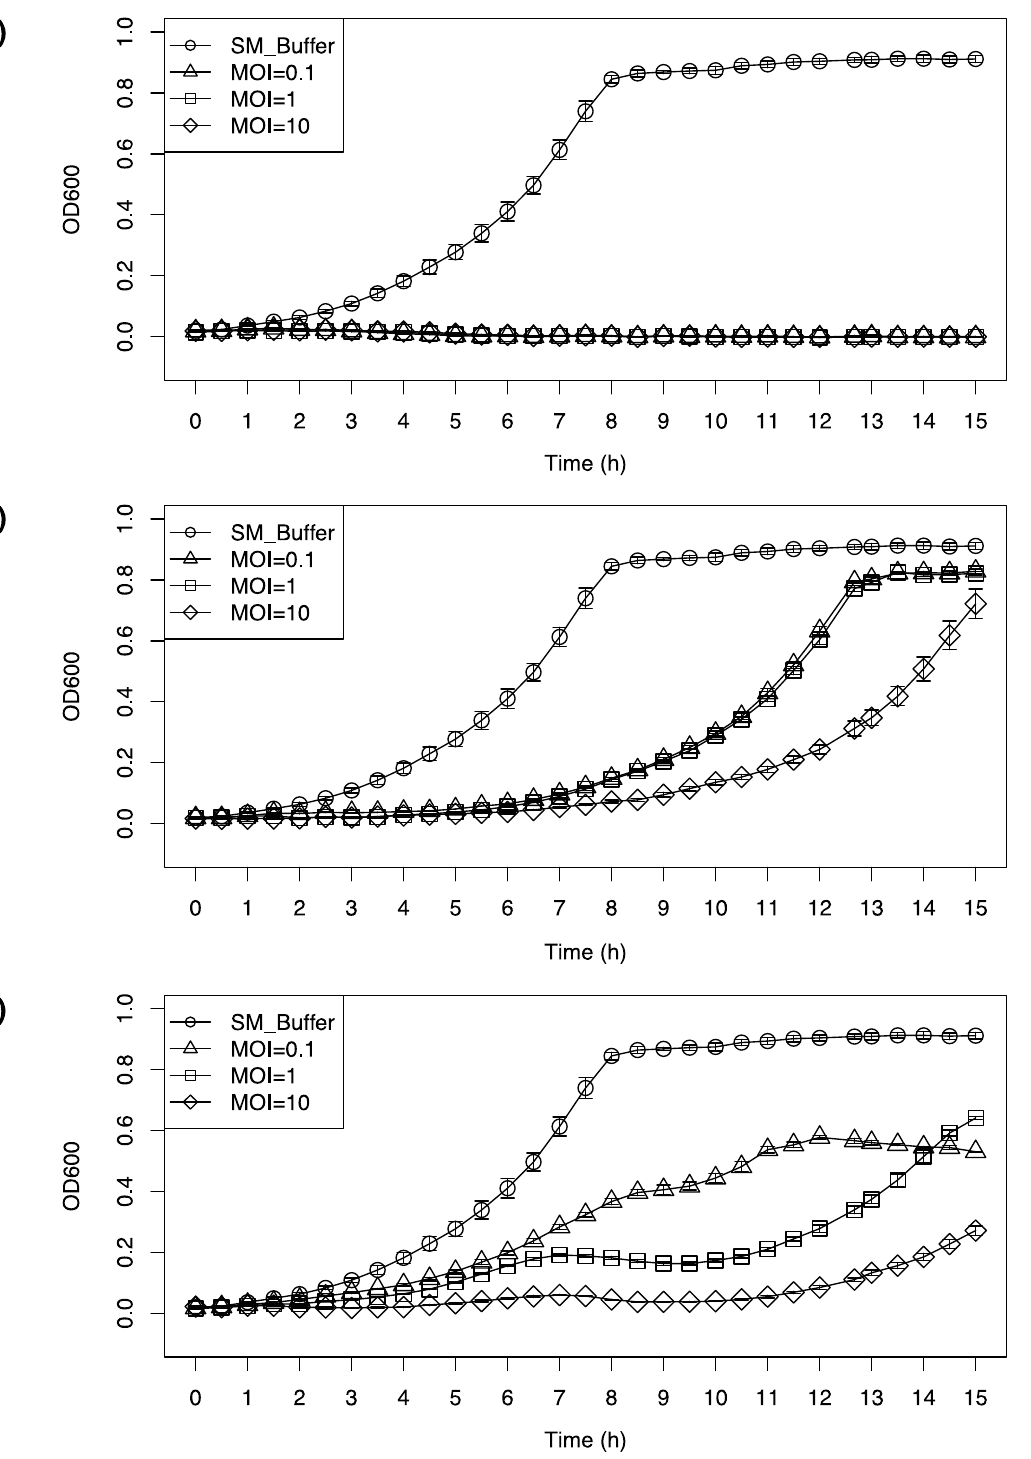
Figure 5. Inhibition growth curve of Listeria monocytogenes F2365 treated with ( A ) LP-020, ( B ) LP-027 or ( C ) LP-094 at different MOIs. Unfilled circles represent SM buffer control, unfilled triangles represent samples treated at an MOI of 0.1, unfilled squares represent samples treated at an MOI of 1, and diamonds represent samples treated at a MOI of 10. Data are mean values of three biological replicates and error bars represent the standard error.